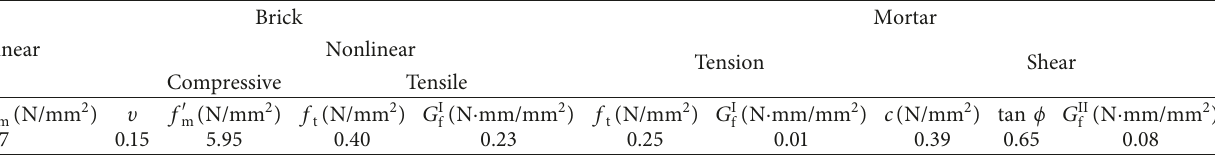
Table 2: Mechanical properties of mortar and bricks in the benchmark